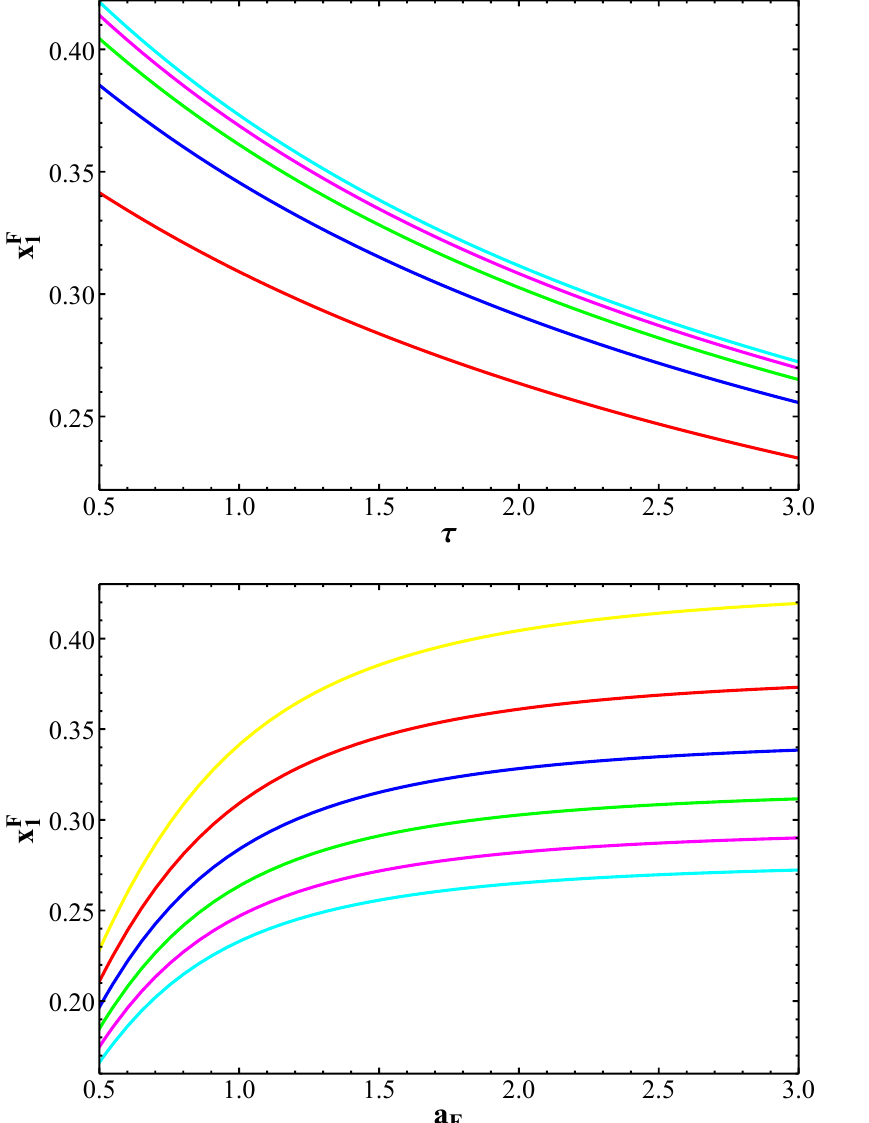
Figure 2 . (Top) Value of the root x F 5/2 and 3, respectively. (Bottom) Value of the root x F τ = 1 / 2 , 1, 3/2, 2, 5/2 and 3,